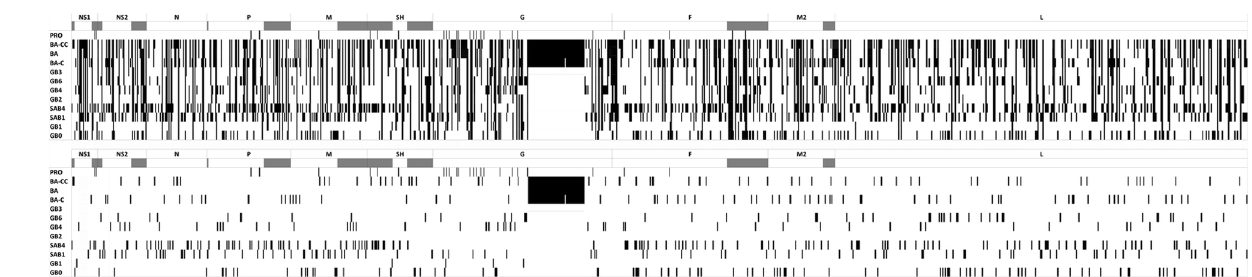
Figure 5. Distribution of molecular markers present in RSV-B genotypes. The location of all (upper panel) and unique (lower panel) molecular markers present in each genotype is shown. Dark bars indicate untranslated regions in which molecular markers were